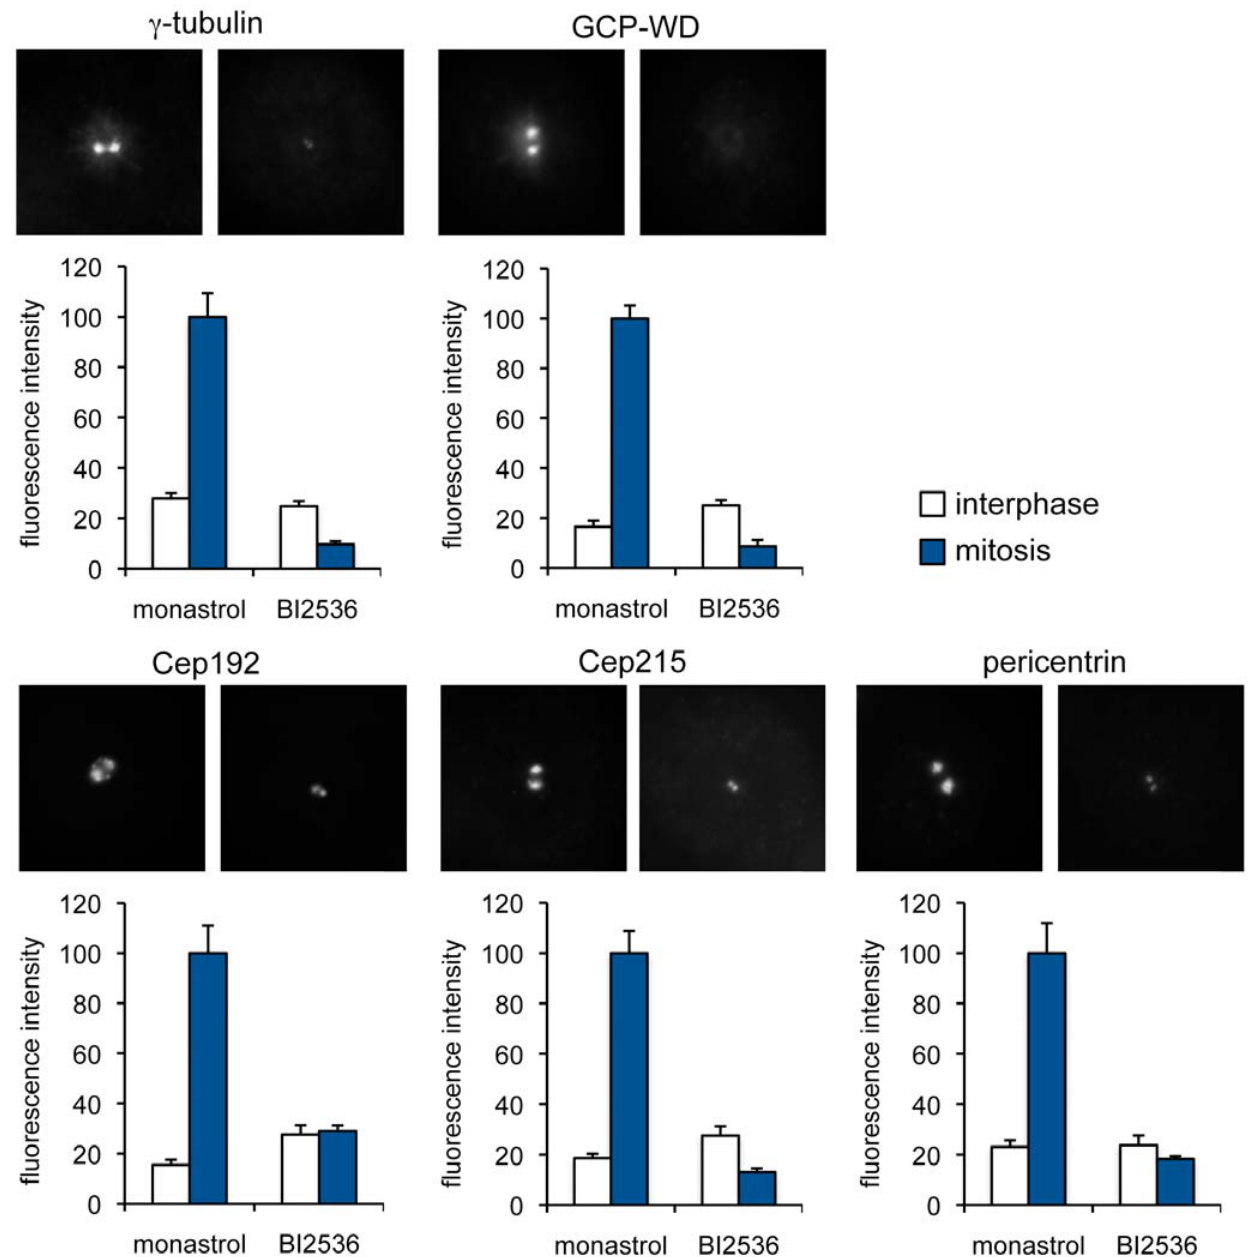
Figure 4. Plk1 inhibition interferes with the recruitment of Cep192, Cep215 and pericentrin to mitotic centrosomes. HeLa cells were treated with monastrol or BI2536, fixed and immunostained for GCP-WD, c -tubulin, Cep192, Cep215 or pericentrin. Fluorescence intensities at the centrosomes were quantified in interphase and in mitosis (n $ 10 cells/20 centrosomes per condition). Intensities were plotted as a percentage of the intensities measured in mitotic cells treated with monastrol. Error bars: SEM, 95% CI.